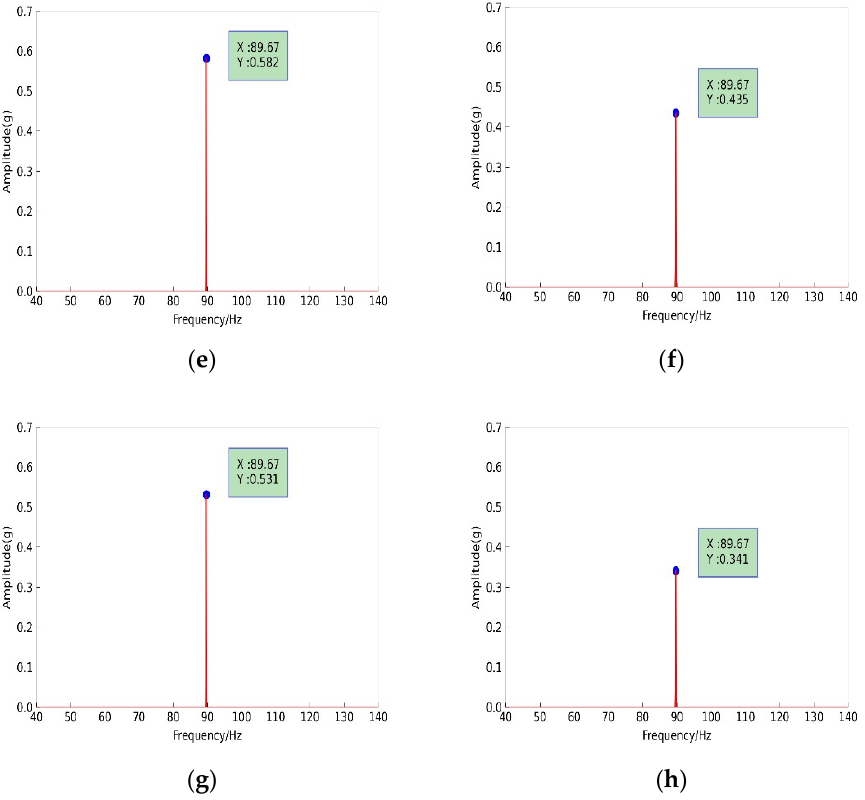
Figure 11. Vibration response under low-pressure constant-frequency excitation: ( a ) TA18 titanium alloy pipeline; ( b ) Nitronic40 stainless-steel pipeline; ( c ) 6061T6 aluminium alloy pipeline; ( d ) specimen no. 1; ( e ) specimen no. 2; ( f ) specimen no. 5; ( g ) specimen no. 6; ( h ) specimen no. 8.